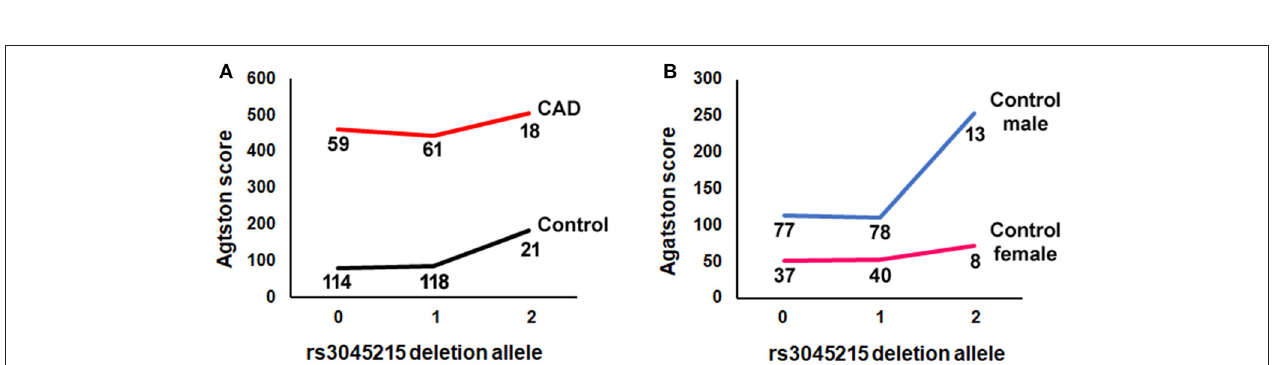
FIGURE 4 | The minor (deletion) allele of rs3045215 associates with coronary artery calcification in men with minimal atherosclerotic burden. (A) Agatston score by number of rs3045215 deletion alleles (0, homozygous for the non-deletion allele; 1, heterozygous; 2, homozygous for the deletion allele) in CAD cases and controls. (B) Agatston score by number of rs3045215 deletion alleles in male and female controls. Numbers below lines are genotyped individuals.